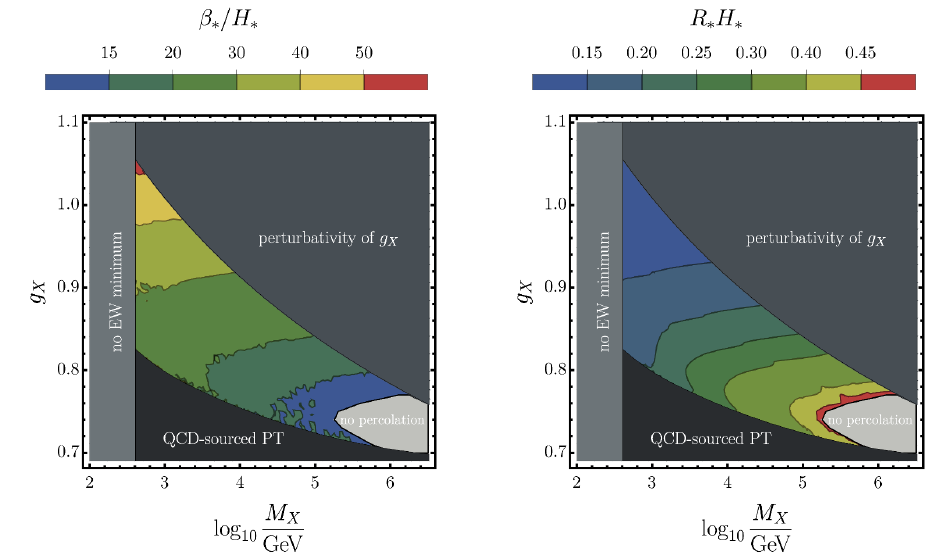
Figure 10 . The values of inverse time scale β/H ∗ (left panel) and the length scale of the transition R ∗ H ∗ (right